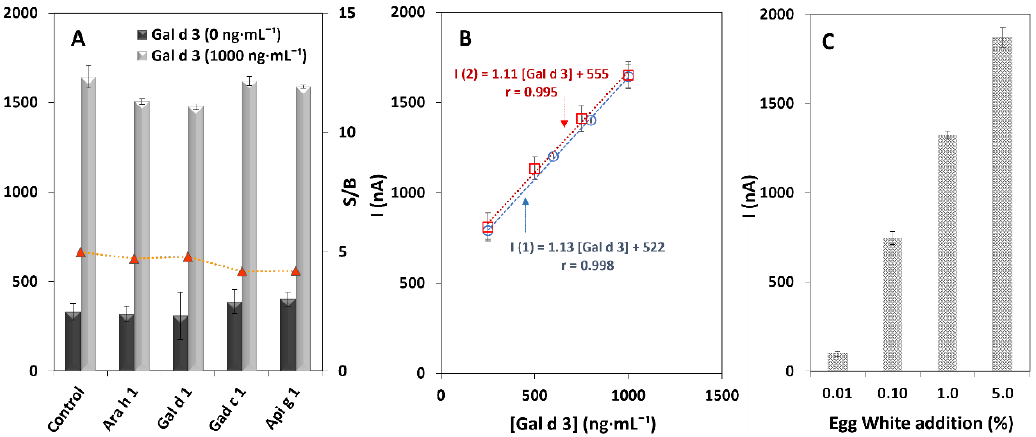
Figure 4. Responses provided by the amperometric immunosensor. ( A ) Selectivity study (i.e., in the absence of Gal d 3) (dark grey bars) and interference evaluation (i.e., Gal d 3 (1000 ng·mL −1 ) mixed with possible interferents) (light grey bars). Tested non-target allergens: Ara h 1, Gal d 1, Gad c 1, and Api g 1 (1000 ng·mL −1 ). ( B ) Comparison between the analysis of Gal d 3 in buffer (I1) and whole-grain extract (I2). ( C ) Addition of increasing amounts of egg white (0.010, 0.10, 1.0, and 5.0% to a food sample (whole-grain extract)).